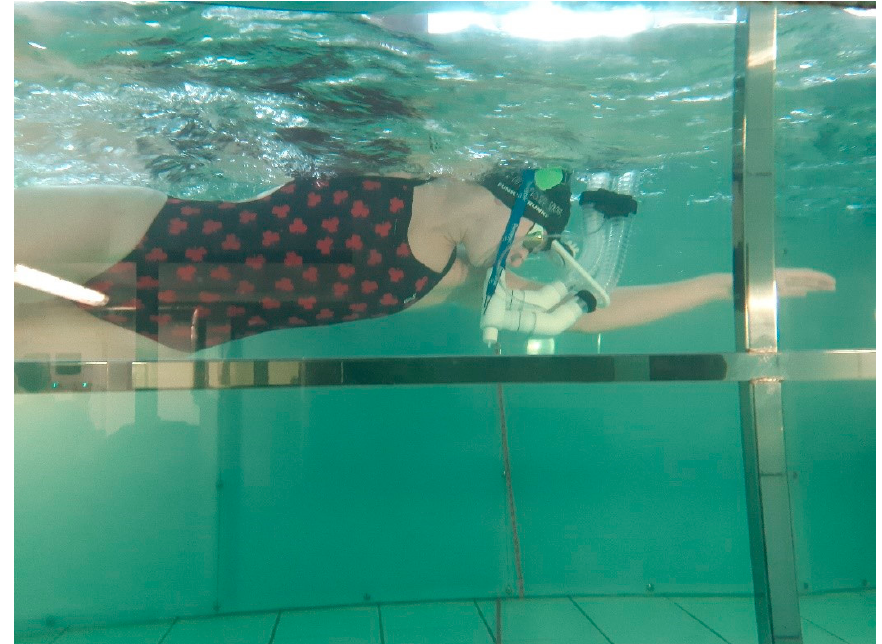
Figure 1. One of the swimmers going through a stage test procedure in a water flume.